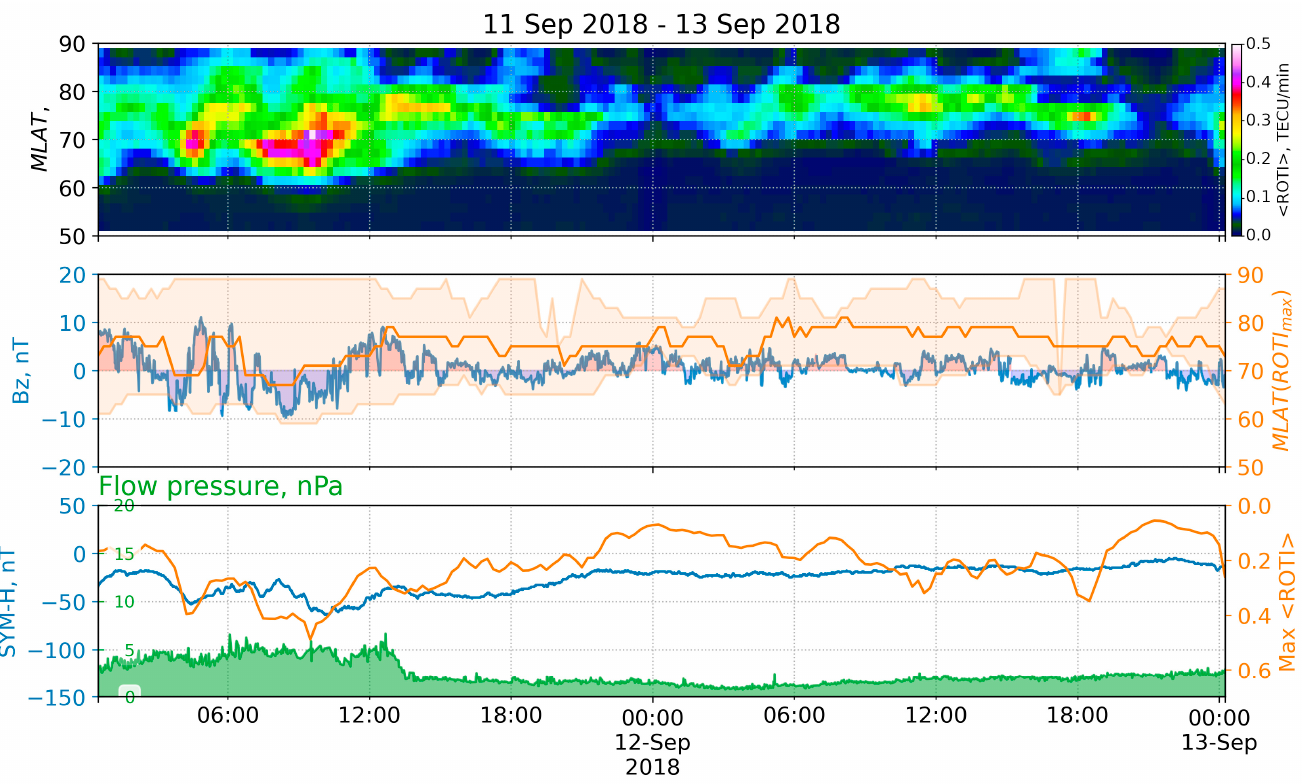
Figure 10. ROTI keogram and space weather parameters for the storm of 11 September 2018: ( top ) keogram of average ROTI (<ROTI> versus MLAT versus time); ( middle ) IMF Bz ( blue ), MLAT positions of maximum <ROTI> ( orange ), and values exceeding median ROTI at the moment ( orange filling ); ( bottom ) SYM-H index ( blue ), <ROTI> max ( orange ), and flow pressure ( green ).